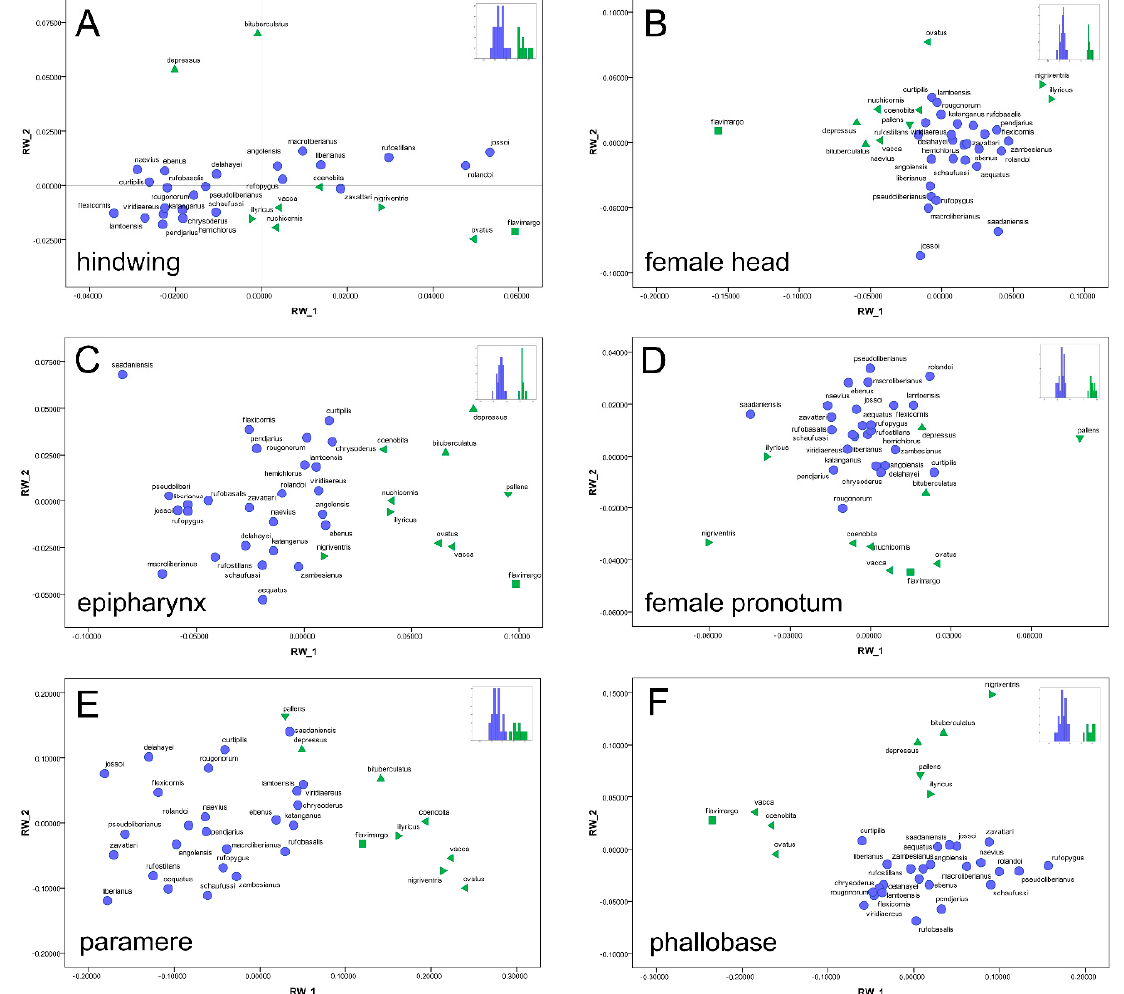
Figure 2. The scatterplots of the two first relative warps of ( A ): Hindwing. ( B ): Female head. ( C ): Epipharynx. ( D ): Female pronotum. ( E ): Paramere. ( F ): Phallobase. In the plots, blue points = ingroup Tiaronthophagus taxa, green points = outgroup taxa. The histogram summarizing the results of canonical variate analysis (CVA) on the whole relative warp (RW) scores is also given.